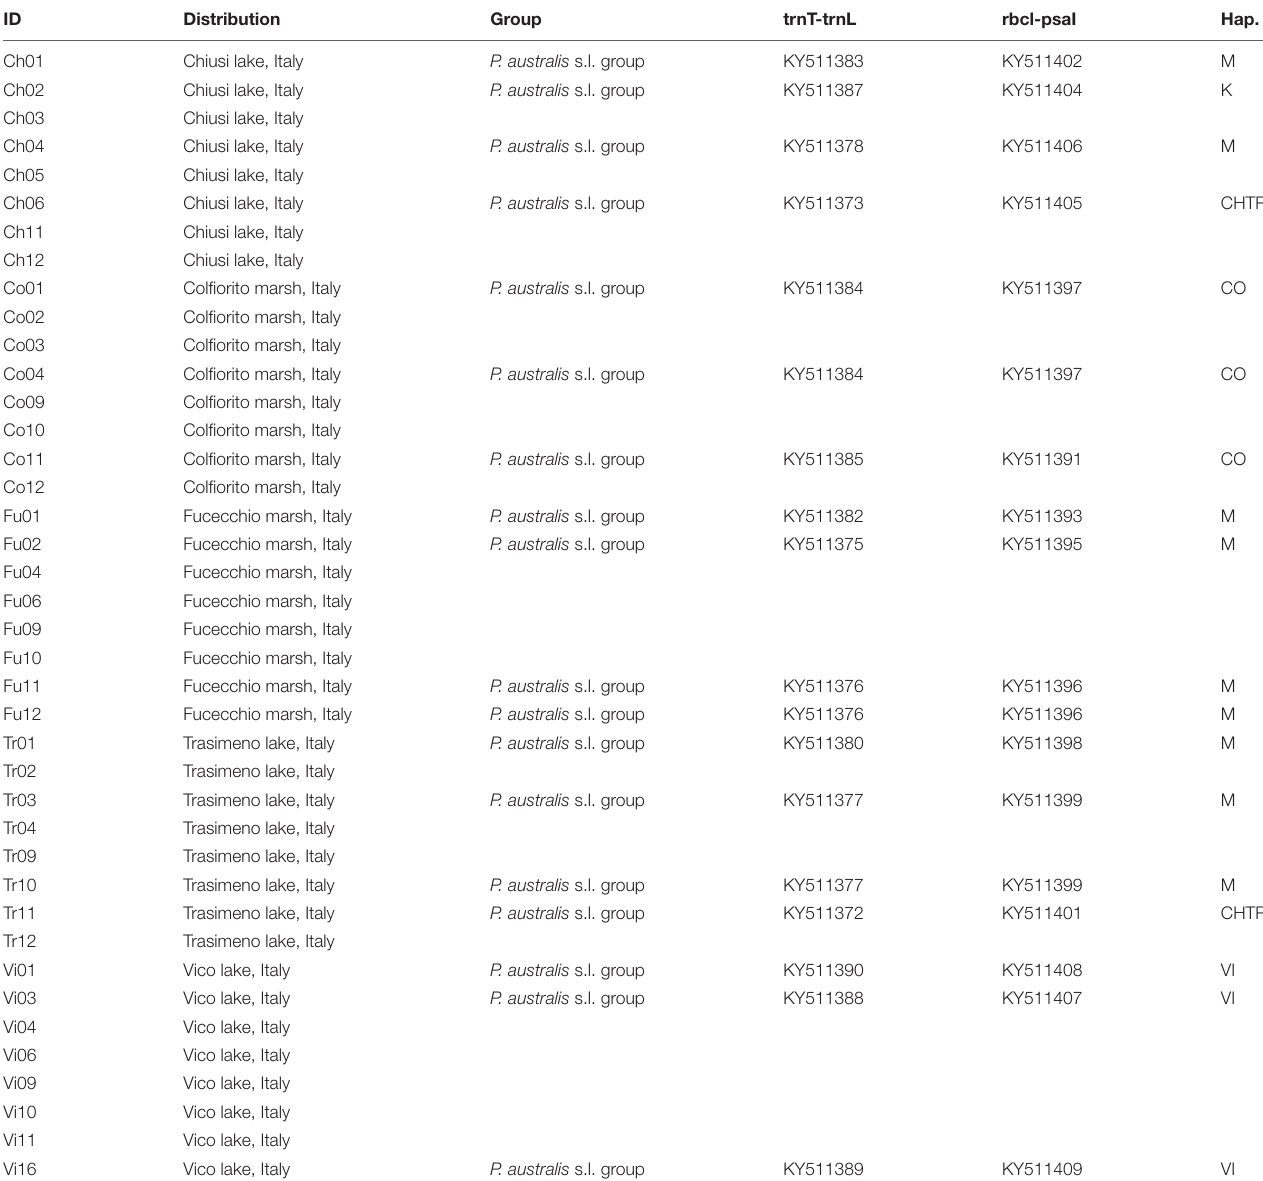
TABLE 1 | List of sampling sites examined for both AFLP and trnL-trnF/rbcl-psaI analyses with: accession codes; main geographic distributions; grouping affiliation codes for analysis of genetic distance (Group); GenBank accessions and haplotype classification. ID Distribution Group trnT-trnL rbcl-psaI